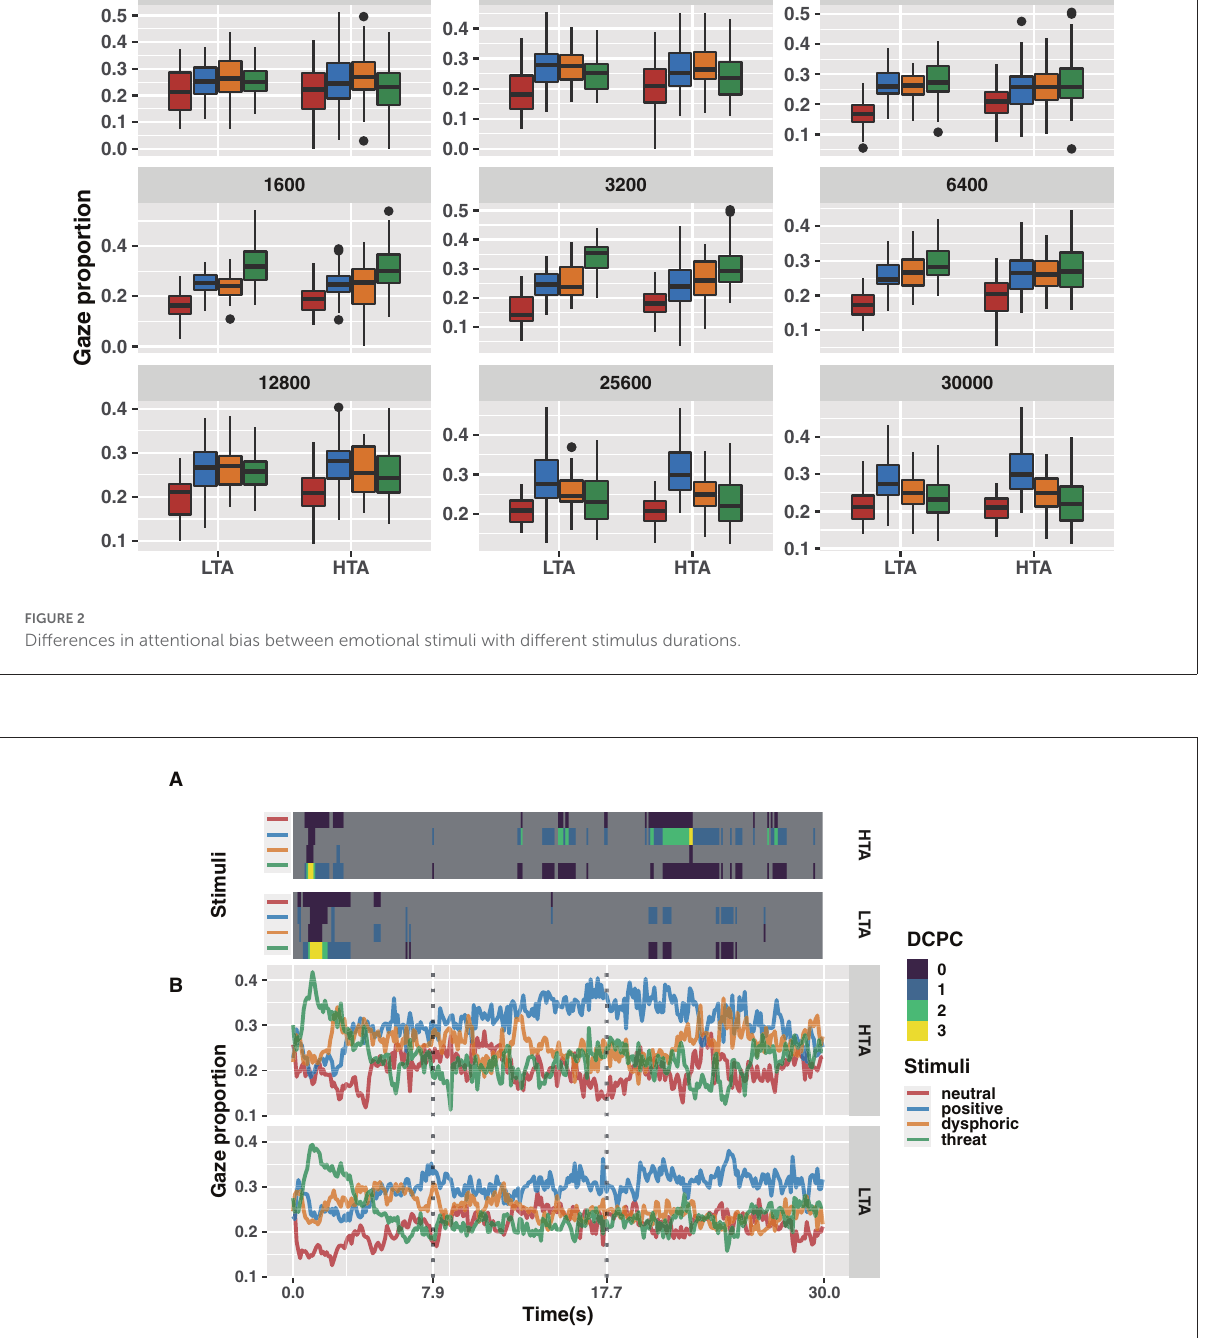
FIGURE3 For each 100ms bin prediction model, dominance count of pairwise comparisons (DCPC, adjusted p-value < 0.05) of HTA and LTA groups (A) . Gaze proportions of the HTA and LTA groups at each emotional stimulus in each 100ms bin (B)